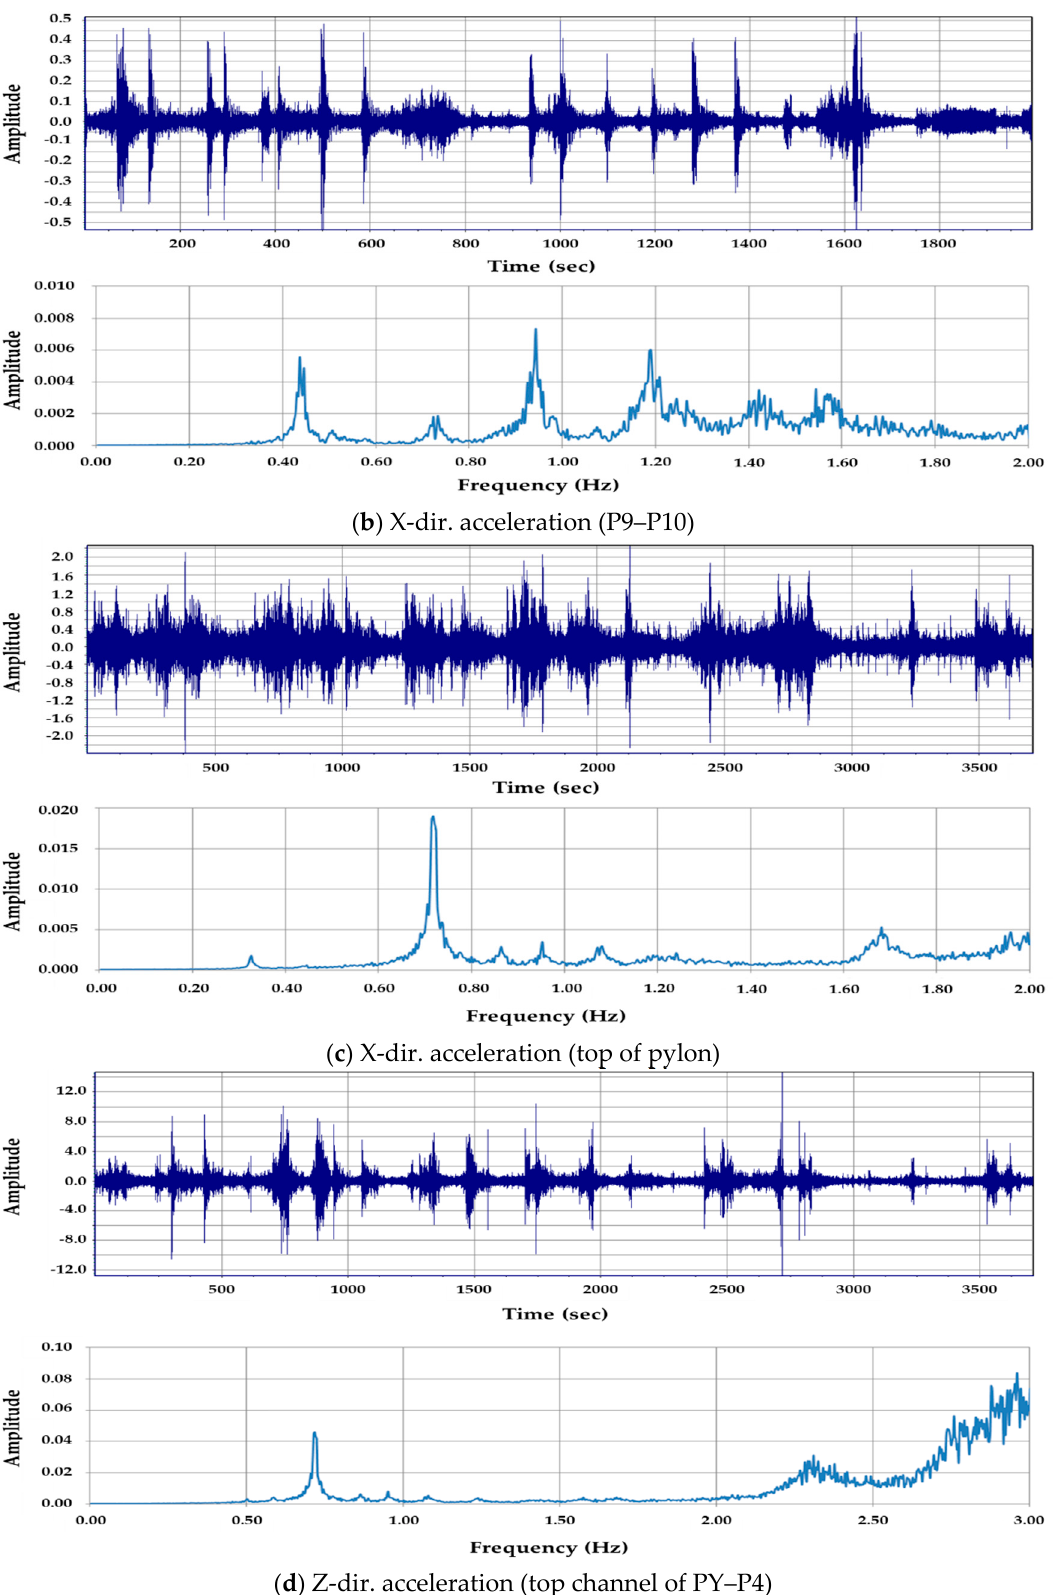
Figure 4. Time history and Fast Fourier Transform of free vibration test. ( a )–( d ) Acceleration data in corresponding positions.